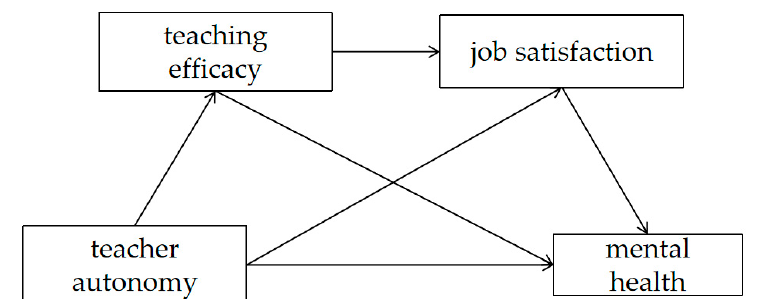
Figure 1. Hypothesized model.